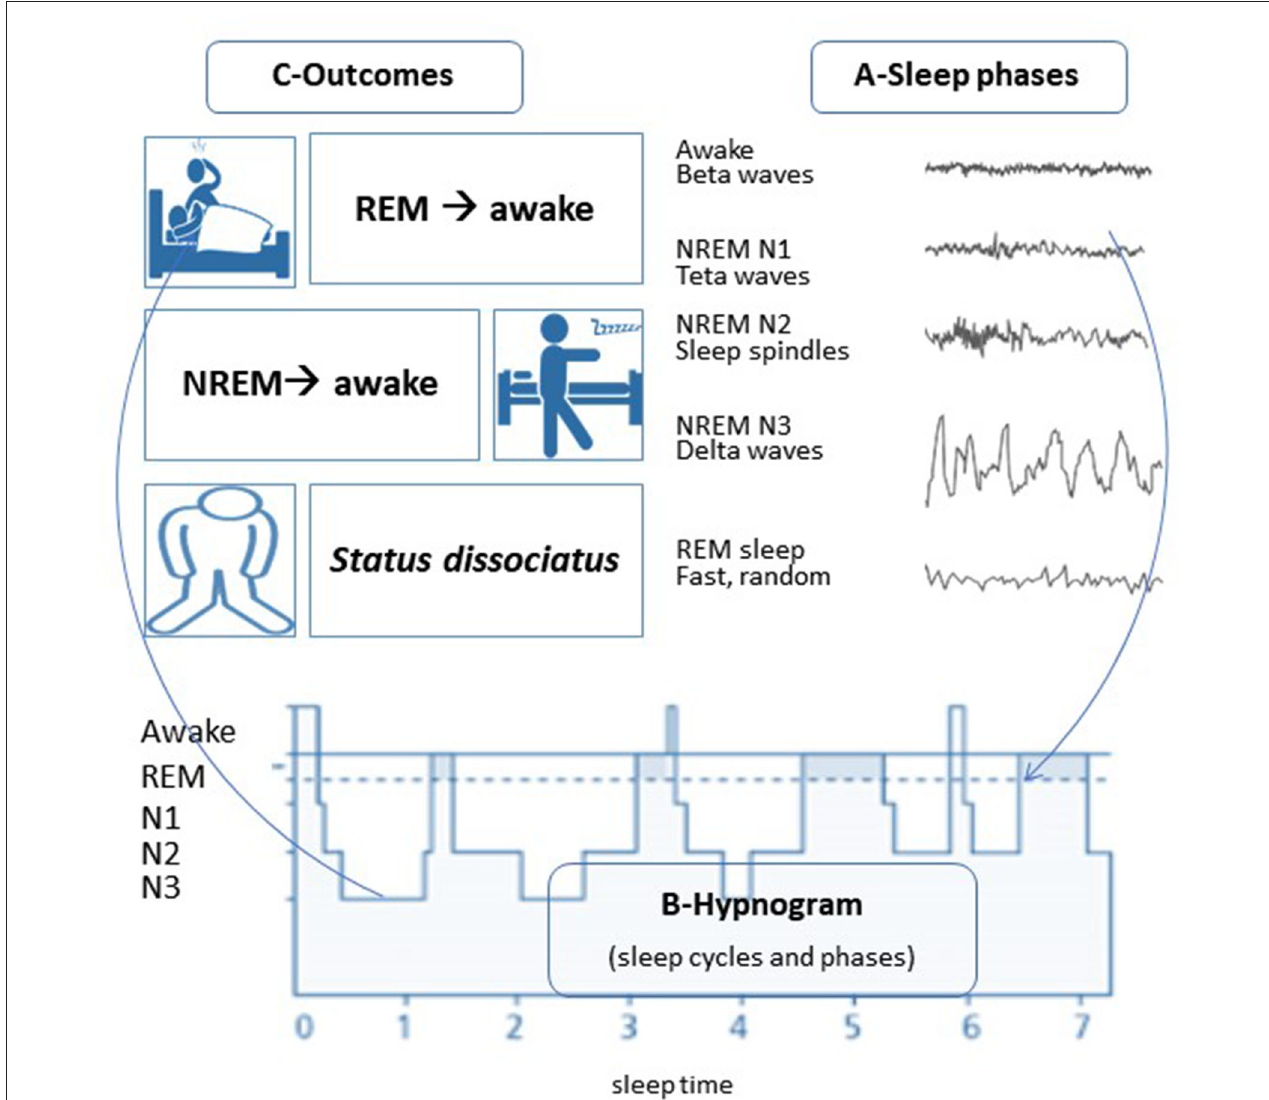
FIGURE 1 | The sleep phases and their intrusions in wakefulness. (A) Sleep phases and their characteristics in EEG, REM, and NREM sleep; (B) Hypnogram (summary of basic sleep characteristics along time) showing sleep cycles, each with sleep phases (NREM-N1, N2, N3, and REM); C- Intrusions of the sleep phases into wakefulness and their results. Illustration by M. da Mota